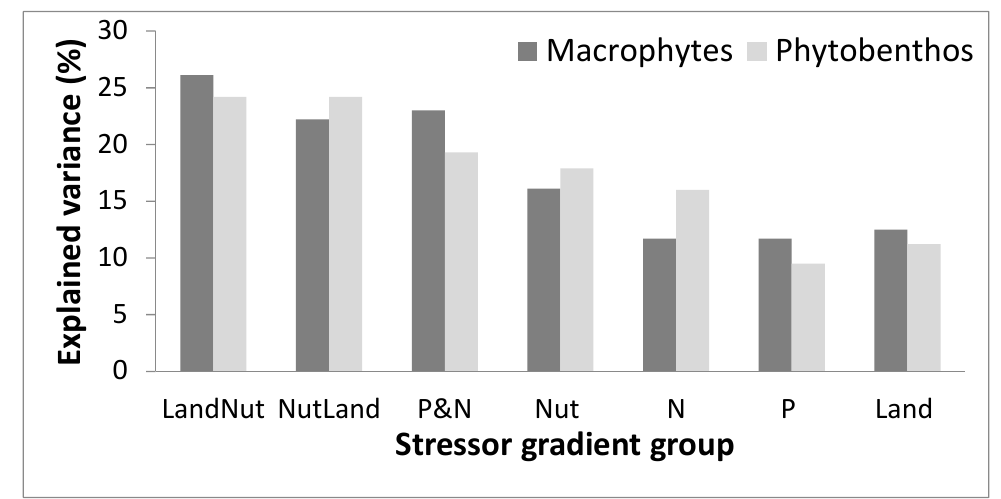
Figure 6. Percentage of explained variance in the macrophytes and phytobenthic assemblages by the stressor gradient groups (LandNut, NutLand; P&N, Nut N and P Land; LandNut—land use and nutrients, NutLand—nutrients and land use, P&N—phosphorous and nitrogen, Nut—phosphorous and nitrogen, N—nitrogen, P—phosphorous, and Land—land use).